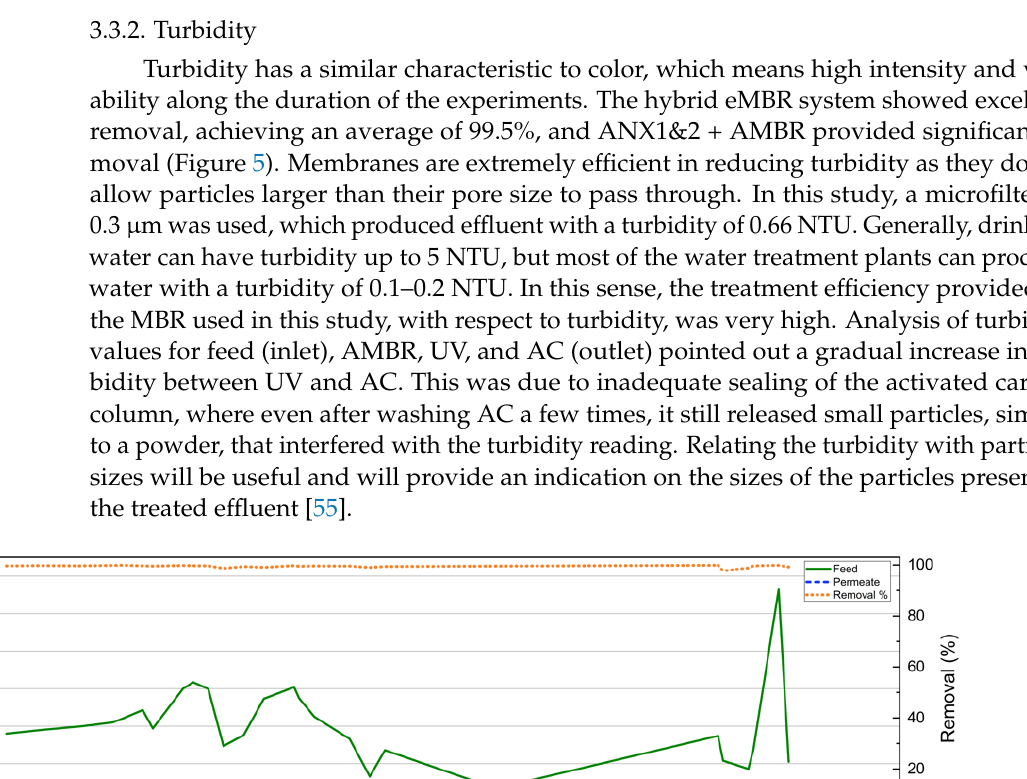
Figure 4. ( a ) Removal and average of the color in the feed and at the outlet of AMBR, UV, and AC during the experimental period, and ( b ) demonstration of color removal by eMBR.